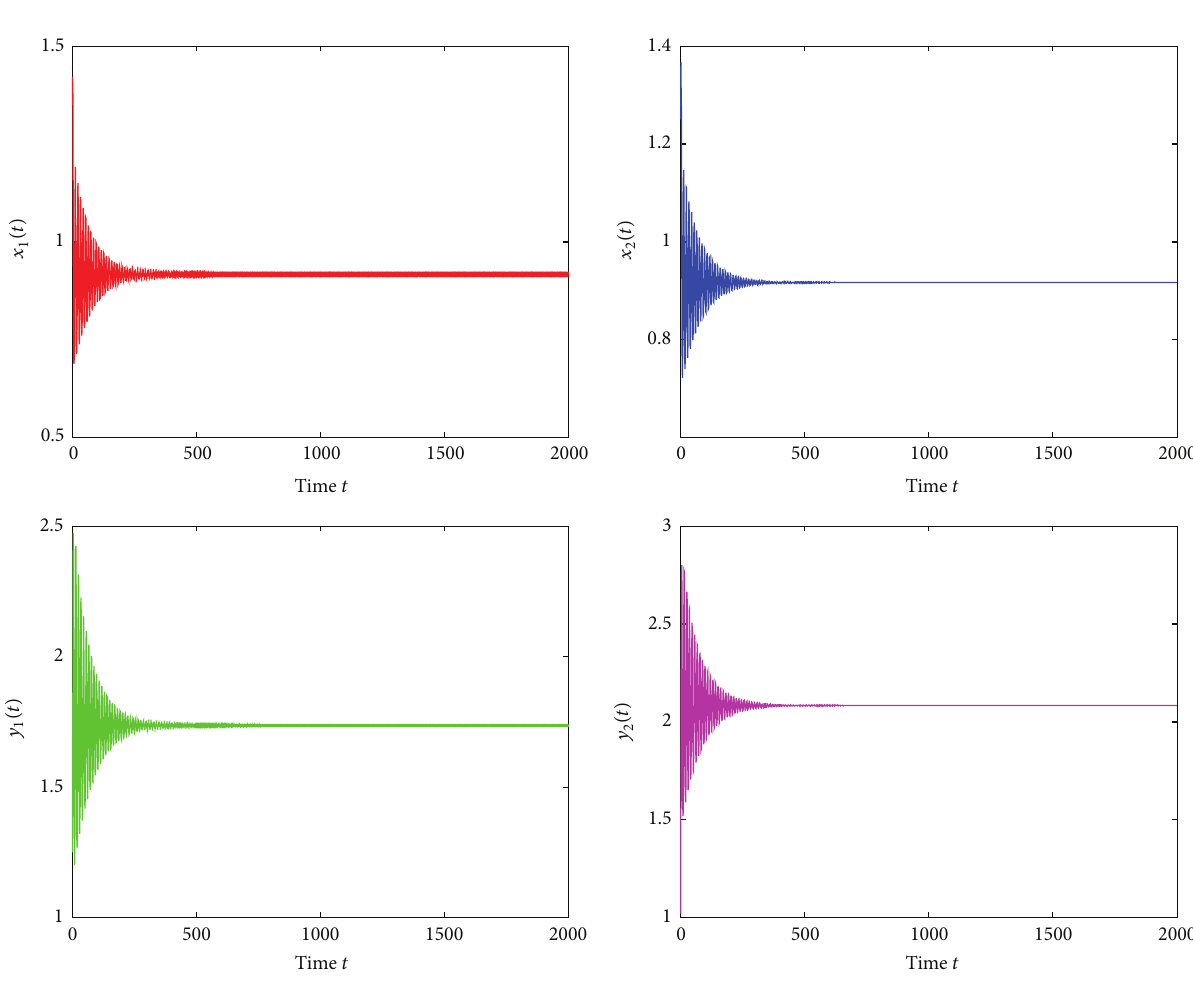
Figure 1: The track of the states 𝑥 1 , 𝑥 2 , 𝑦 1 , 𝑦 2 for 𝜏 1 = 4.2500 < 𝜏 10 = 4.5061 .